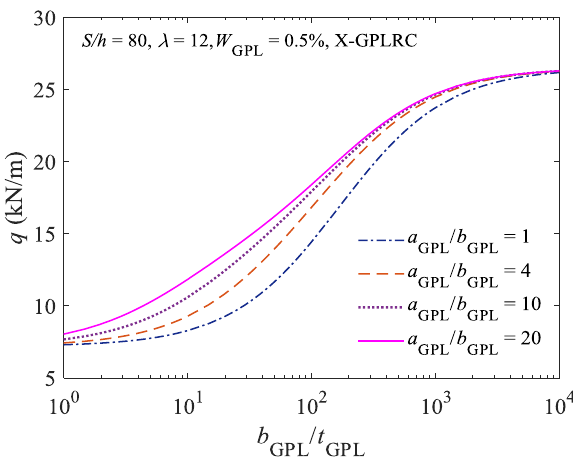
Figure 5. Effect of GPLs geometric dimensions on the limit point buckling load.